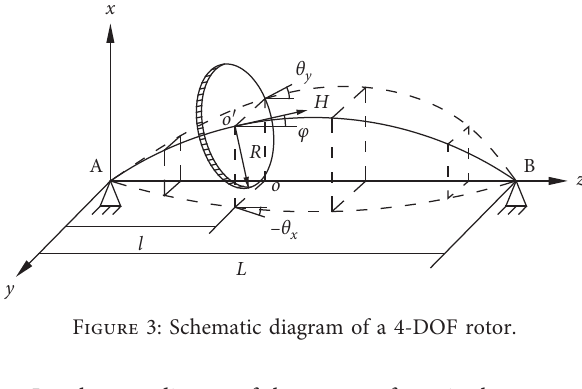
Figure 3: Schematic diagram of a 4-DOF